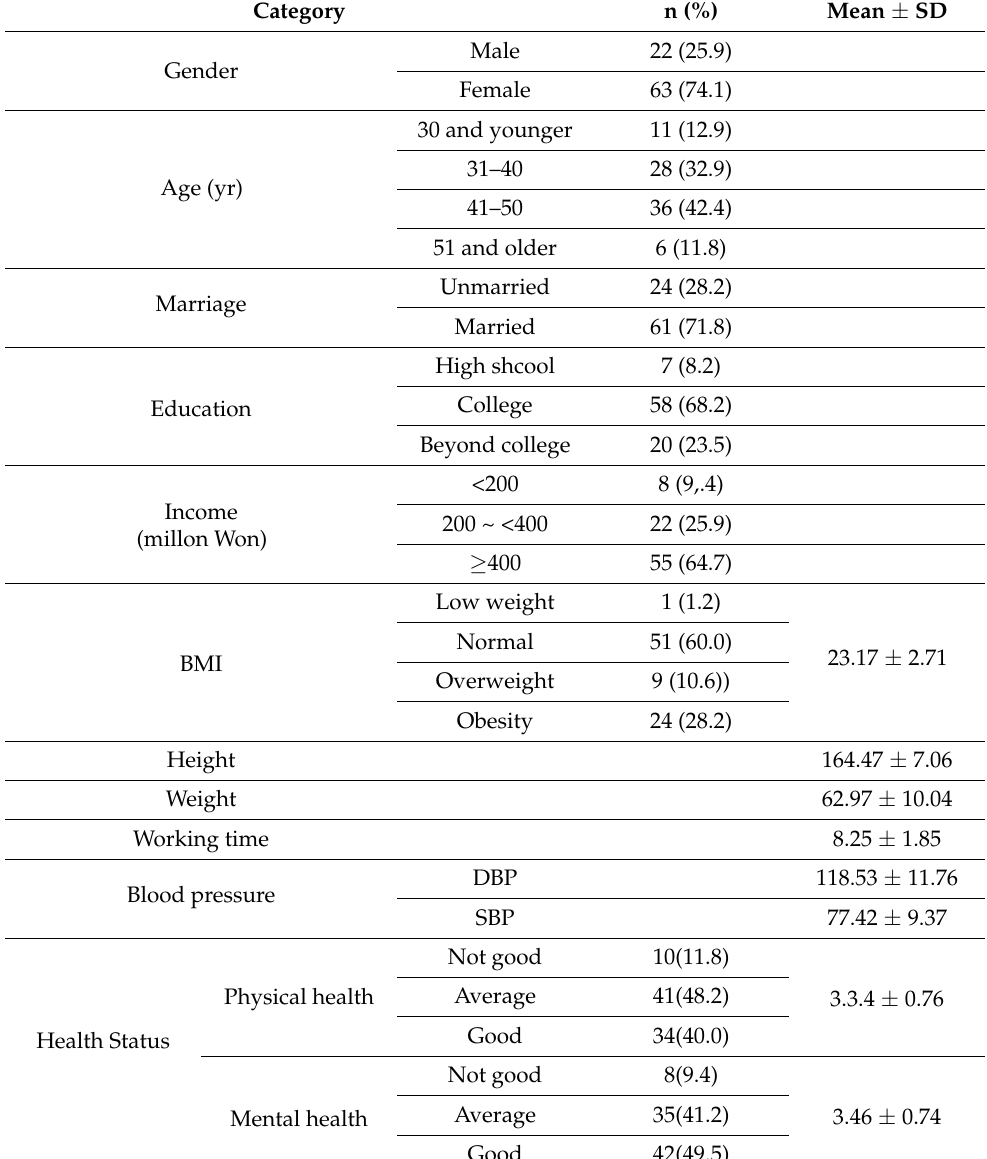
Table 1. General Characteristics of Participants ( N = 85).